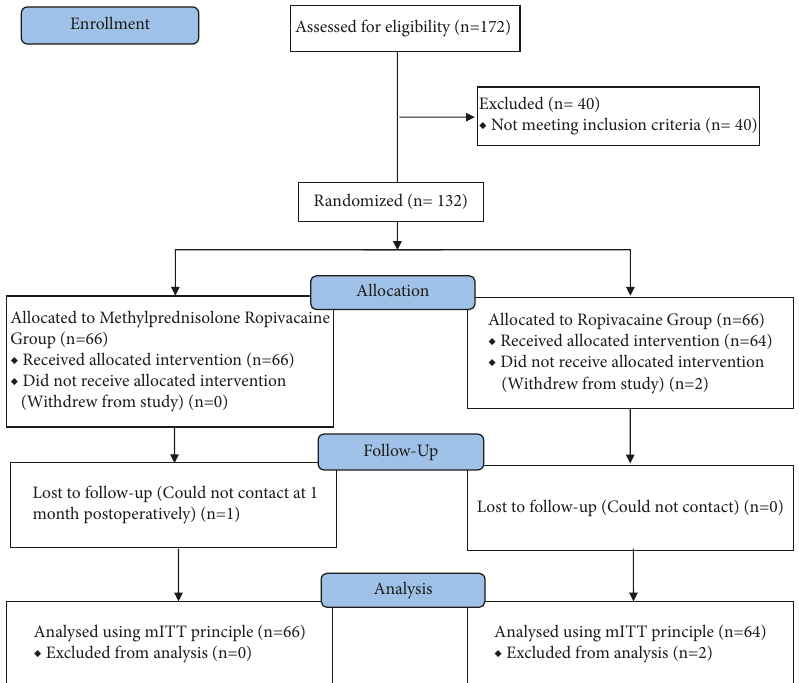
Figure 1: The CONSORT patient flow diagram showing numbers analysed in each